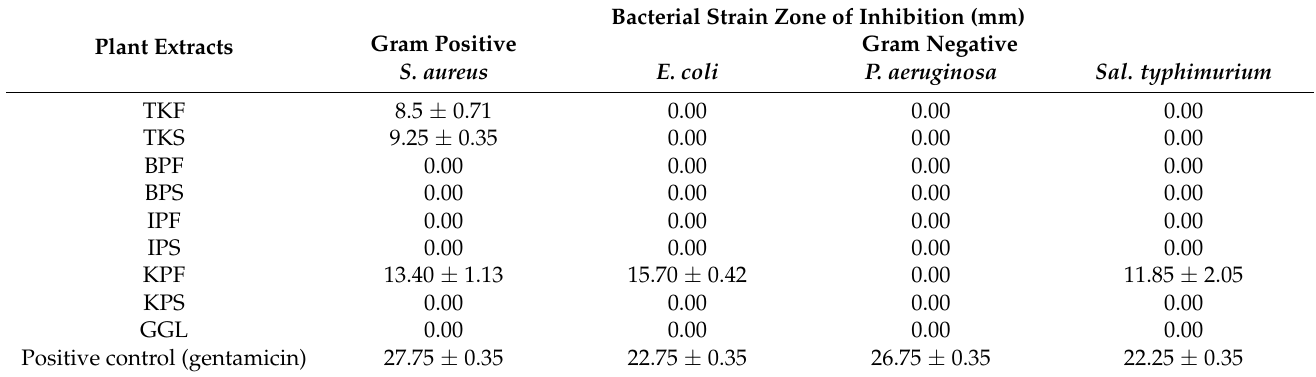
Table 3. Average zone of inhibition ( n = 3) of the crude plant extracts at a concentration of 20 mg/mL. Plant Extracts